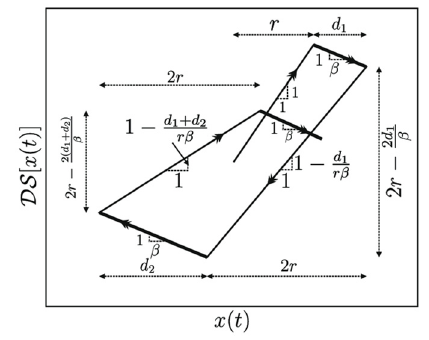
Figure 2. Schematic hysteresis loop of an DS operator [22] .